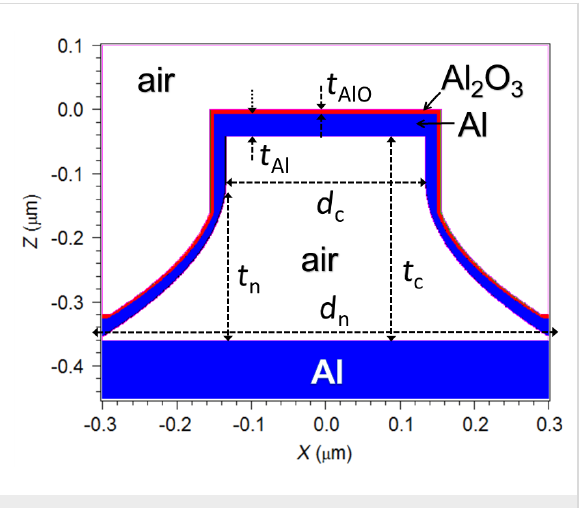
Figure 6: Cross-section of the modelled hollow nanopillar array unit cell. White, blue and red regions correspond to air, Al and Al oxide ma- terials, respectively. Reflectance is calculated assuming light impinging from the air-topped cladding in the − z